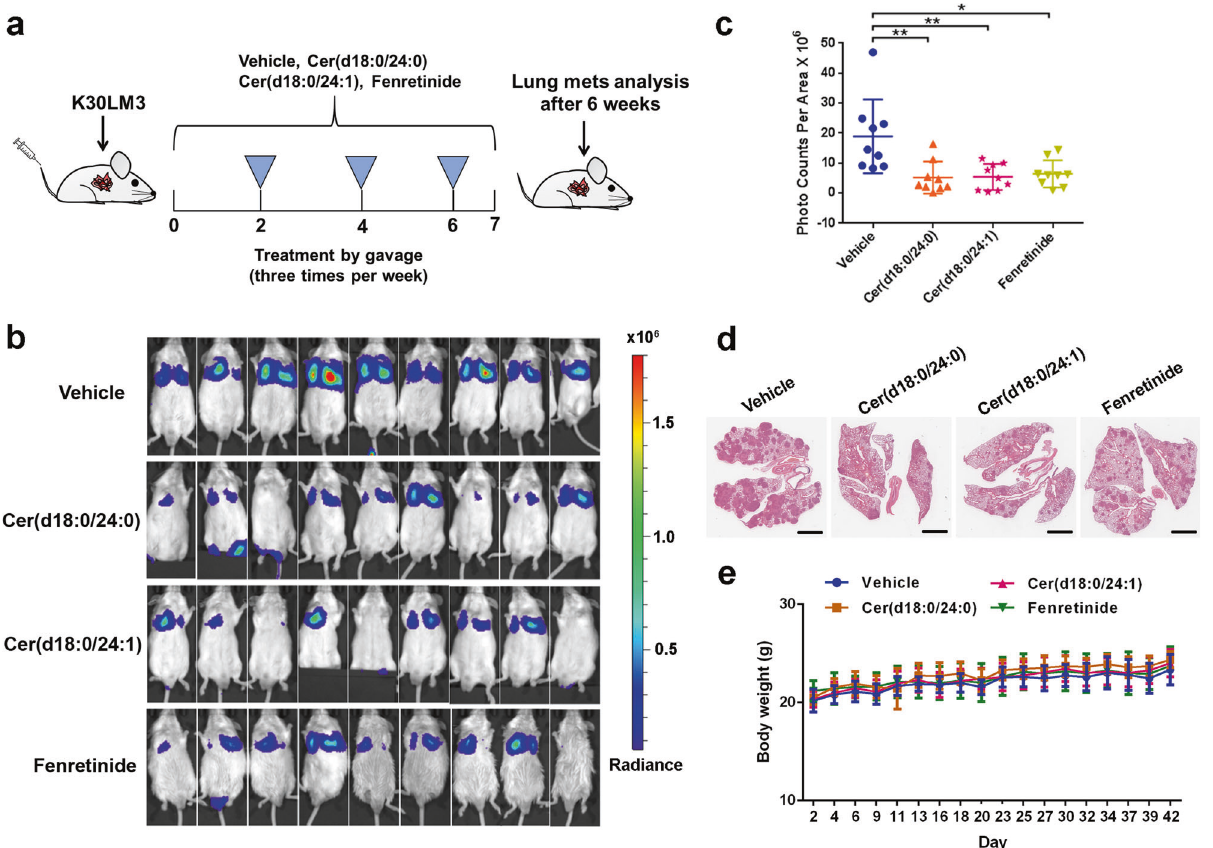
Fig. 4 Cer (d18:0/24:0) and Cer (d18:0/24:1) interfere with metastasis. a Schematic representation showing details for therapeutic ef fi cacy evaluation of Cer(d18:0/24:0), Cer(d18:0/24:1) or fenretinide treatment on an experimental lung metastasis model. b Bioluminescence quanti fi cation of lung colonization by K30LM3 treated with Cer(d18:0/24:0), Cer(d18:0/24:1), fenretinide or vehicle control. c Statistical analysis of bioluminescence quanti fi cation of lung colonization by K30LM3 in each treatment condition. d Representative H&E staining showing lung metastasis lesions in K30LM3 injected mice treated with Cer(d18:0/24:0), Cer(d18:0/24:1), fenretinide or vehicle control. Scale bar, 3 mm. e The effect of Cer(d18:0/24:0), Cer(d18:0/24:1), fenretinide or vehicle treatment on mice body weight was recorded. Error bars denote mean ± SD. * P < 0.05, ** P <